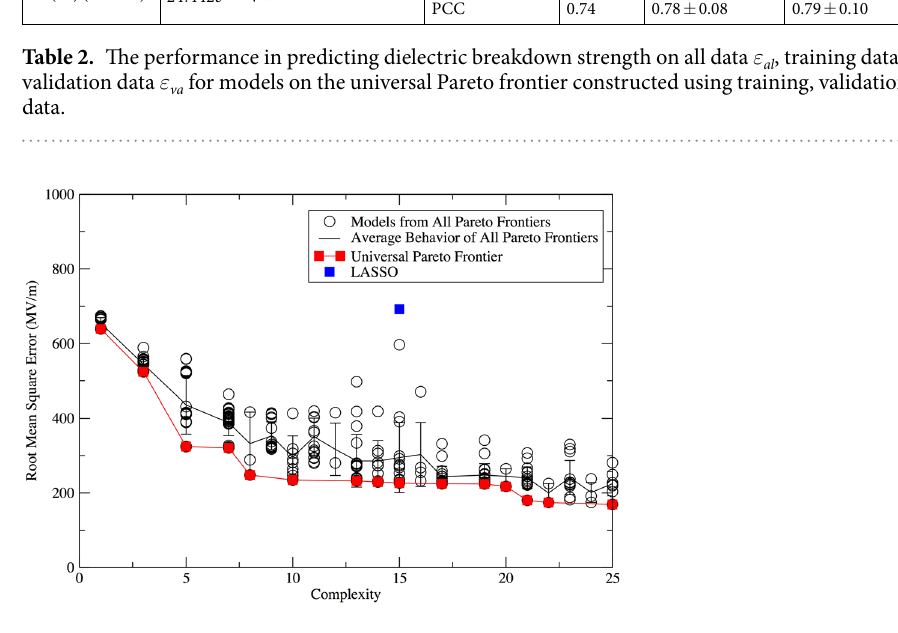
Figure 8. RMSE performance of models on all data (i.e., training + validation + test) for LASSO, the universal Pareto frontier, and models from all Pareto frontiers trained on all data when using dielectric breakdown strength as the output